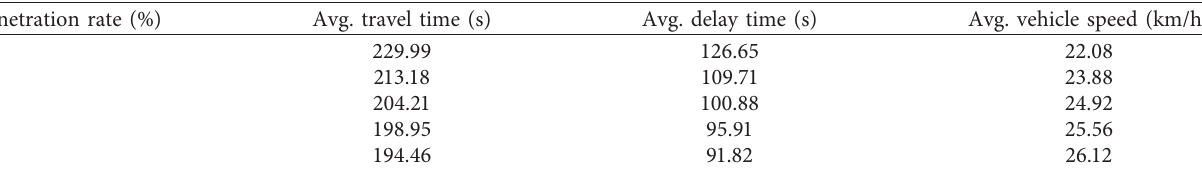
Table 2: Summary of road network performance by AV penetration